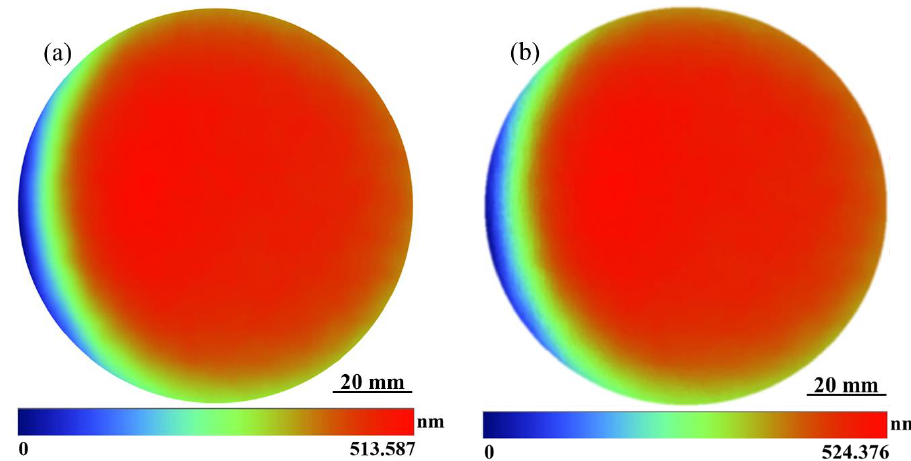
Figure 10. ( a ) Surface profile measured with new algorithm. ( b ) Surface profile measured with the FUJINON interferometer.